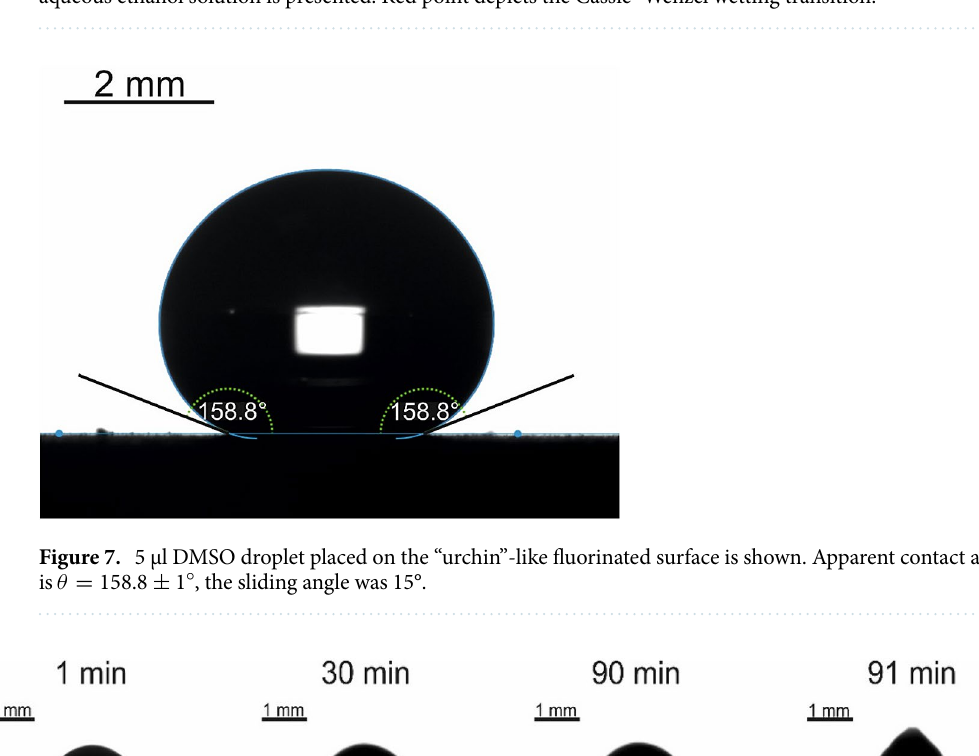
Figure 6. The experimentally established dependence of the apparent contact angle vs. the surface tension of aqueous ethanol solution is presented. Red point depicts the Cassie–Wenzel wetting transition.